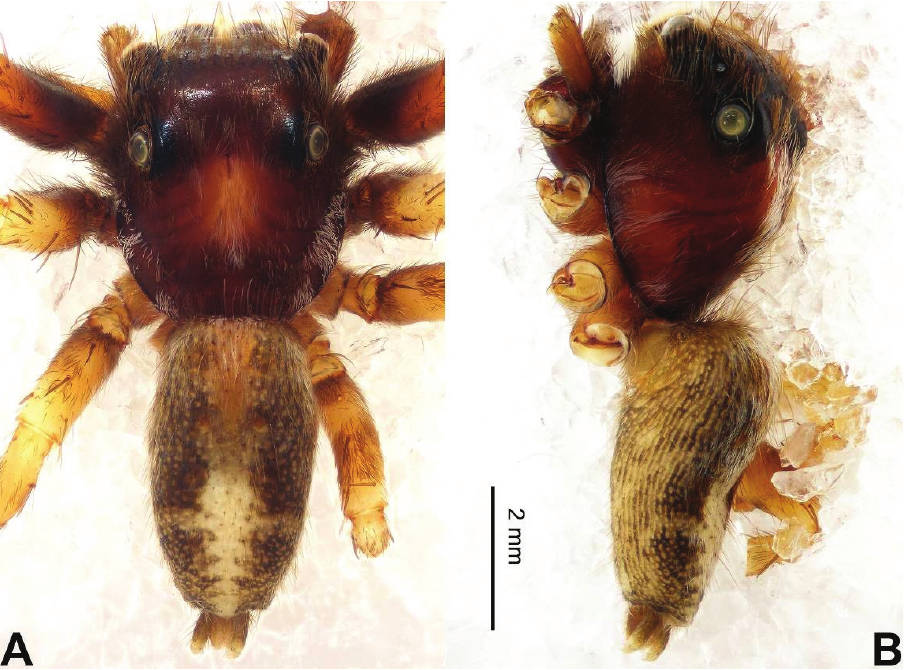
Figure 31. Habitus of Pancorius latus sp. n., male holotype. A dorsal B lateral. Etymology. From Latin latus (wide), in reference to the shape of the carapace;